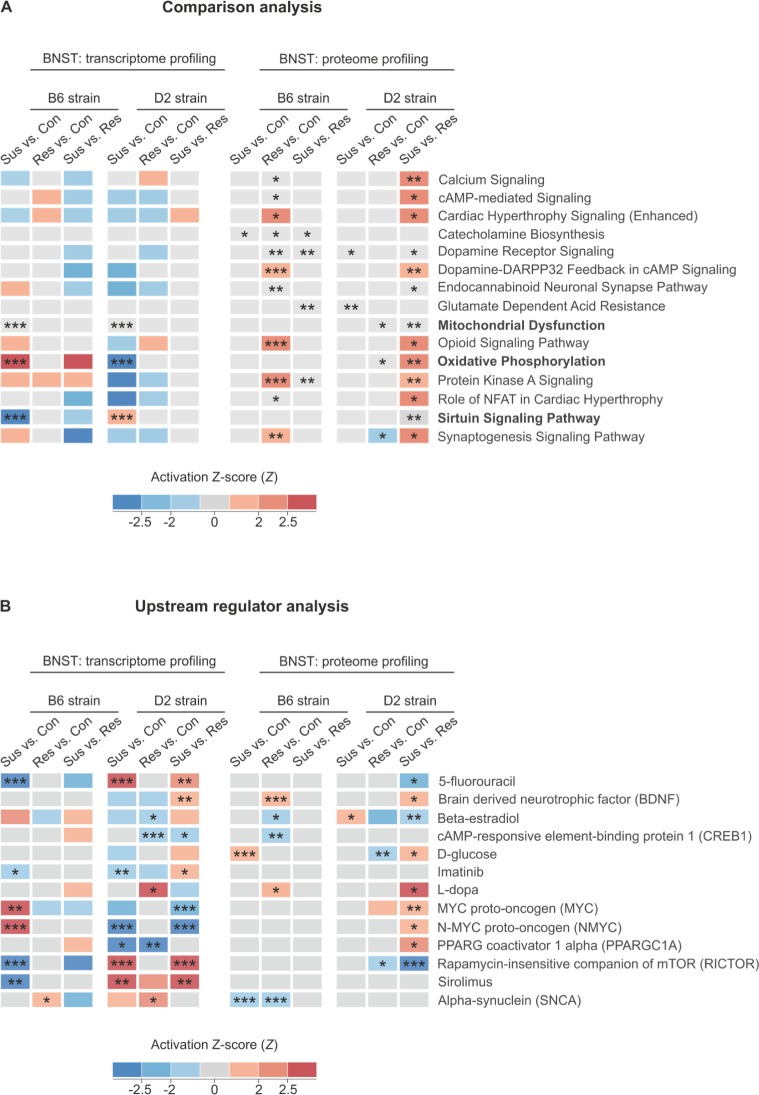
Transcriptomic and proteomic analyses implicate dysregulation of mitochondria-related canonical pathways in the BNST of B6 and D2 mice following CSDS.Merged heatmap showing (A) significantly dysregulated canonical pathways and (B) upstream regulators from the Ingenuity Pathway Analysis (IPA) database ordered alphabetically. Mitochondria-related canonical pathways (written in bold) were found to be significantly dysregulated (PFDR < 0.05) on both gene and protein levels. The IPA Z-score, predicting the activation (red) or inhibition (blue) of the respective signaling pathway or upstream regulator cluster, is marked in color. B6: C57BL/6NCrl; cAMP: cyclic adenosine monophosphate; Con: control; D2: DBA/2NCrl; DARPP-32: dopamine- and cAMP-regulated phosphoprotein; NAFT: nuclear factor of activated T-cells; PPARG: peroxisome proliferator-activated receptor gamma; Res: resilient; Sus: susceptible. *PFDR < 0.05, ** PFDR < 0.01, *** PFDR < 0.001.